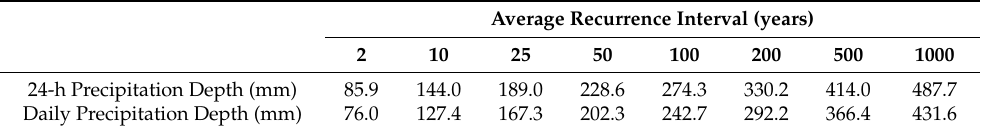
Table A1. Point precipitation depth estimates for the study site from Perica et al.